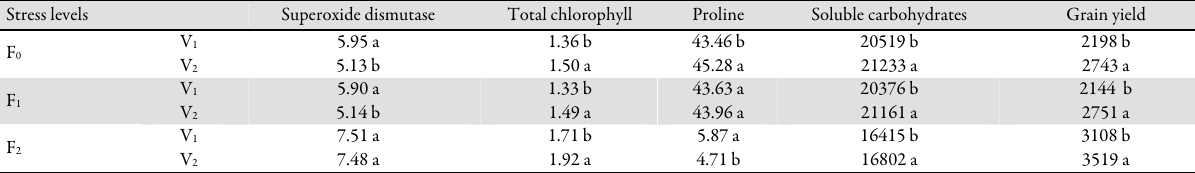
Table 5. Interaction effect of variety and foliar application in yield and physiological traits of two soybean cultivars Stress